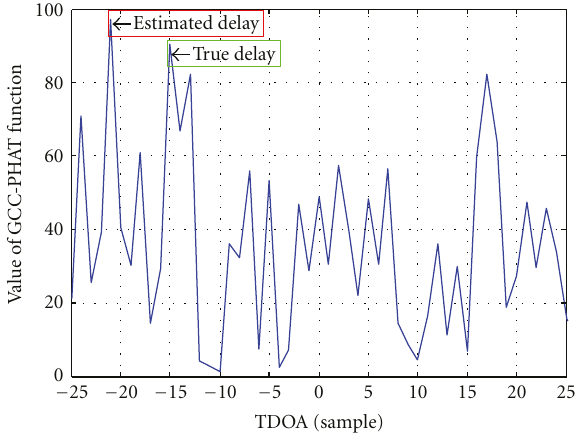
Figure 1: Typical curve of GCC